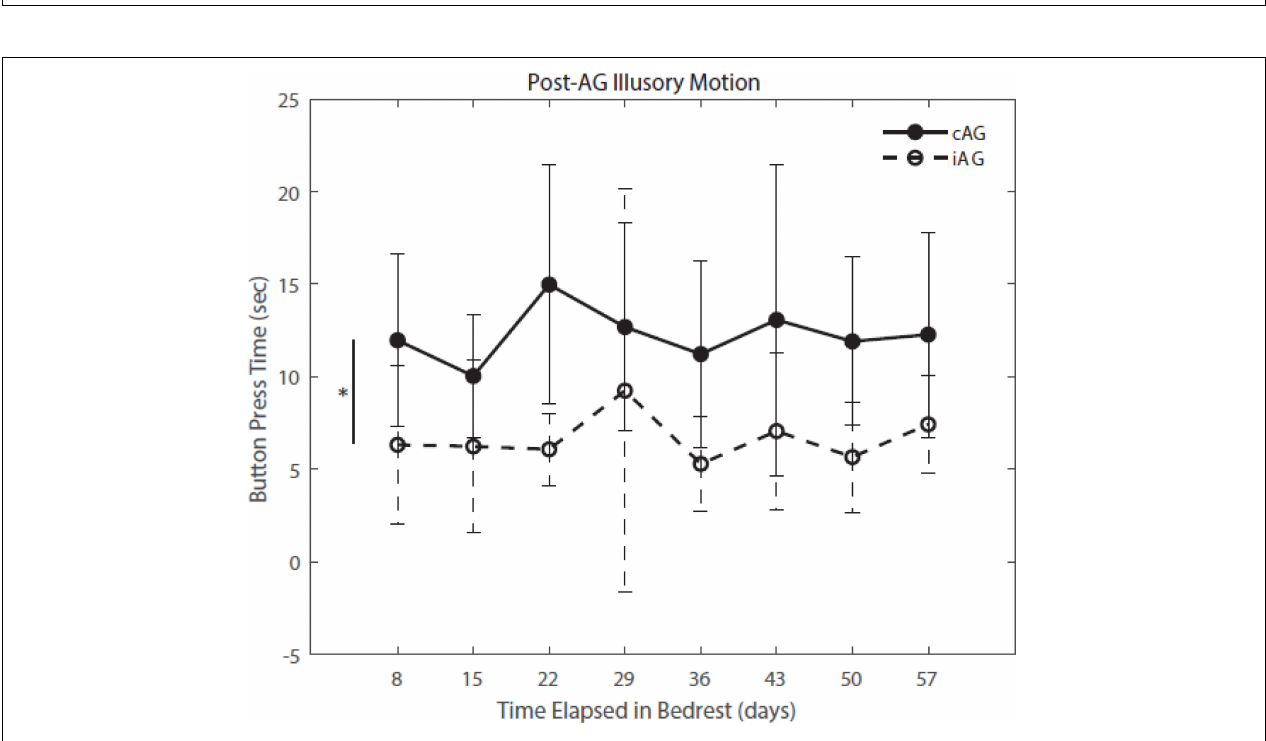
FIGURE 6 | Post-AG Illusory Motion throughout HDBR. Post-AG response times indicate that iAG had a lower level of post-AG illusory motion ( p = 0.036), indicating that they perceived coming to a stop sooner than the cAG participants.